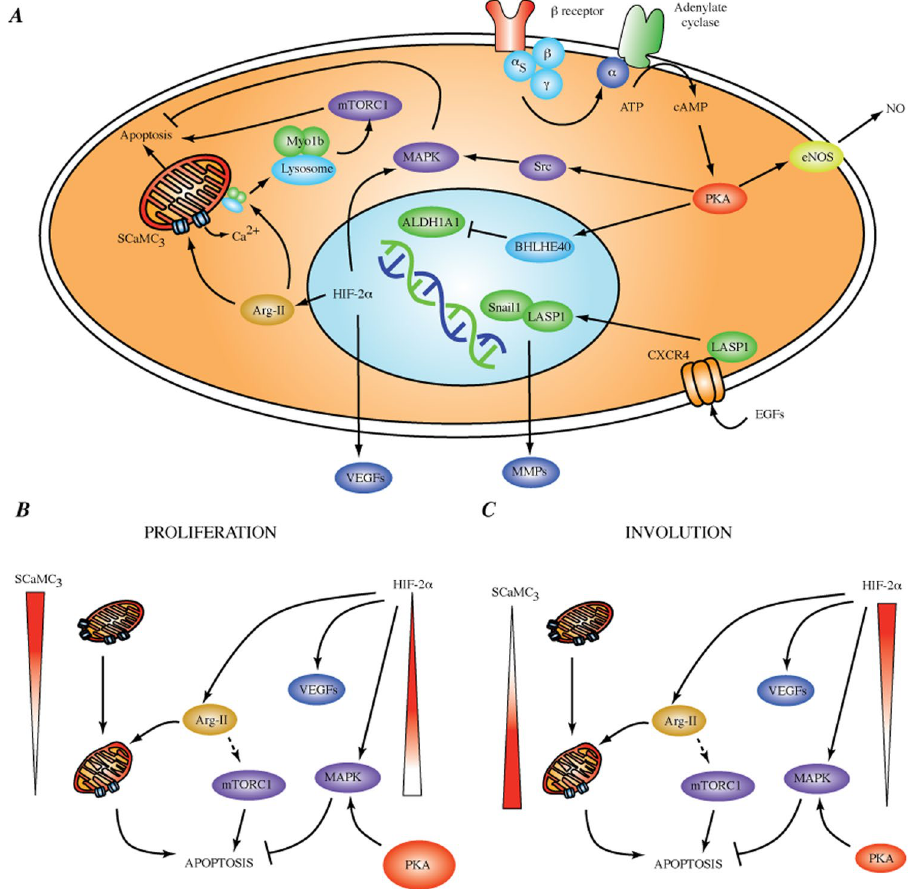
Figure 5. Putative Toxicological Transcriptome Biomarkers and their role on IHs and possible mechanism of action of propranolol. ( A ) Pathways affected by biomarkers. ( B ) Proliferation. High levels of PKA and SCaM C provide an antiapoptotic environment. Decline in the calcium carriers induces mitochondria stress; the up- regulation of HIF-2 α stimulates VEGFs but it has the side effect of increasing levels of Arg-II exacerbating apoptotic pathways. ( C ) Involution. Despite the autoregulatory increase of SCaM C VEGFs by HIF-2 α , the antiapoptotic signals cannot be overcome due to the lack of PKA-induced MAPK survival